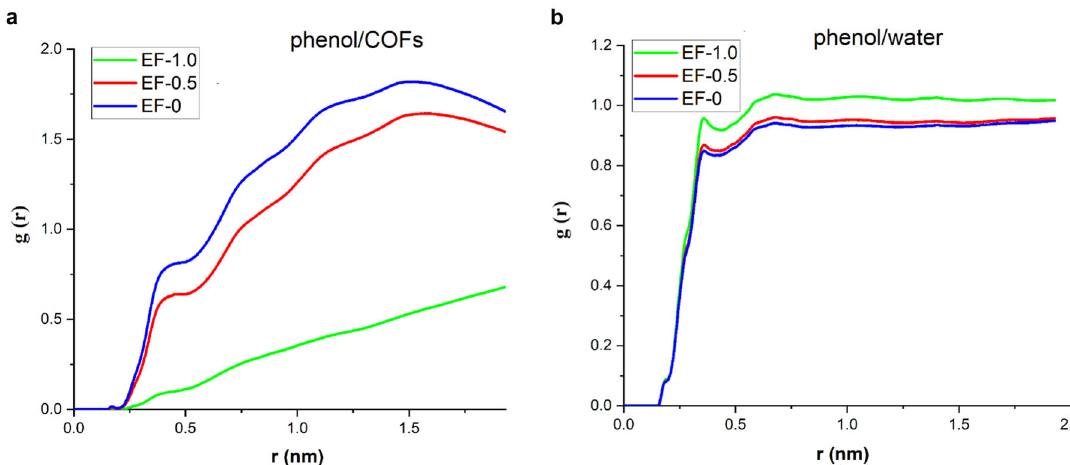
Fig. 3 RDF patterns. a Between phenol and COFs. b Between phenol and water.